Question: Sum up the contents of this chart in one sentence.
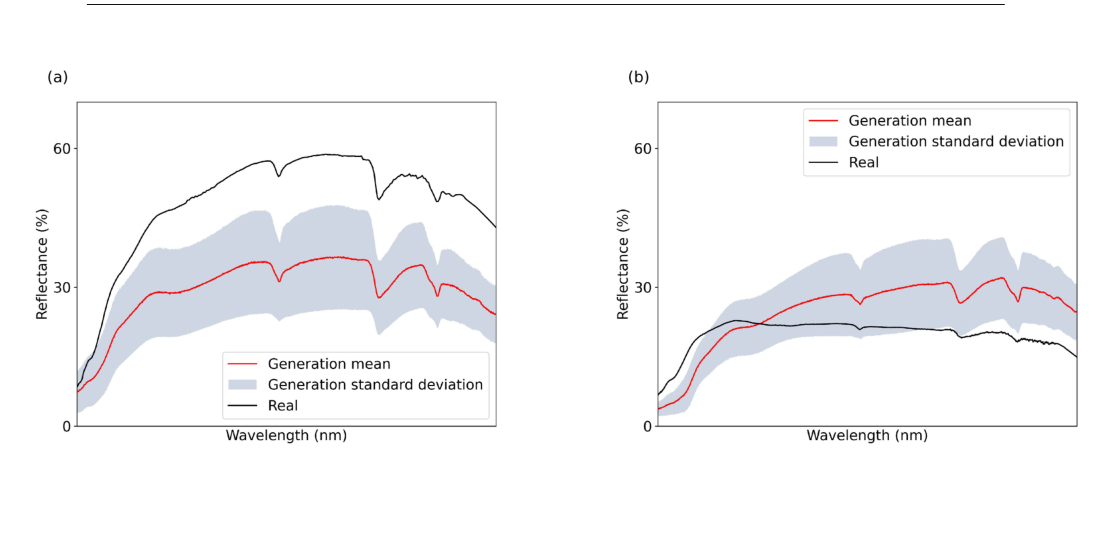
Answer: Example real soil reflectance spectra and mean and standard deviation of generated soil reflectance spectra with similar soil particle fraction properties and spectrometer manufacturer (ASD). (a) Clay : 22.0%; Silt : 26.0%; Sand : 52.0%. (b) Clay : 17.3%; Silt : 26.1%; Sand : 56.6%.